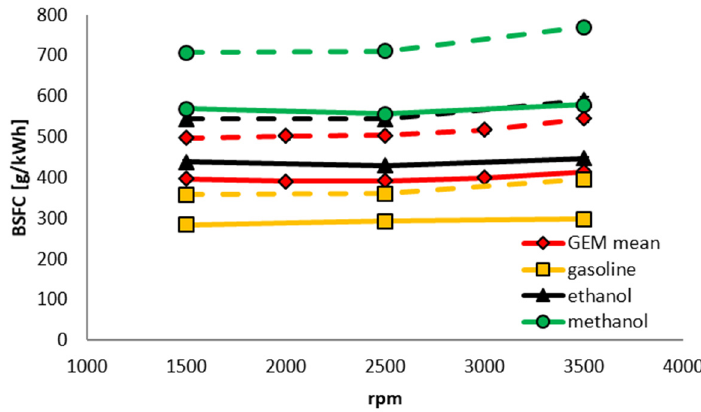
Figure 15. BSFC as a function of engine speed for different fixed brake torques of 40 Nm (dashed lines) and 80 Nm (solid lines).